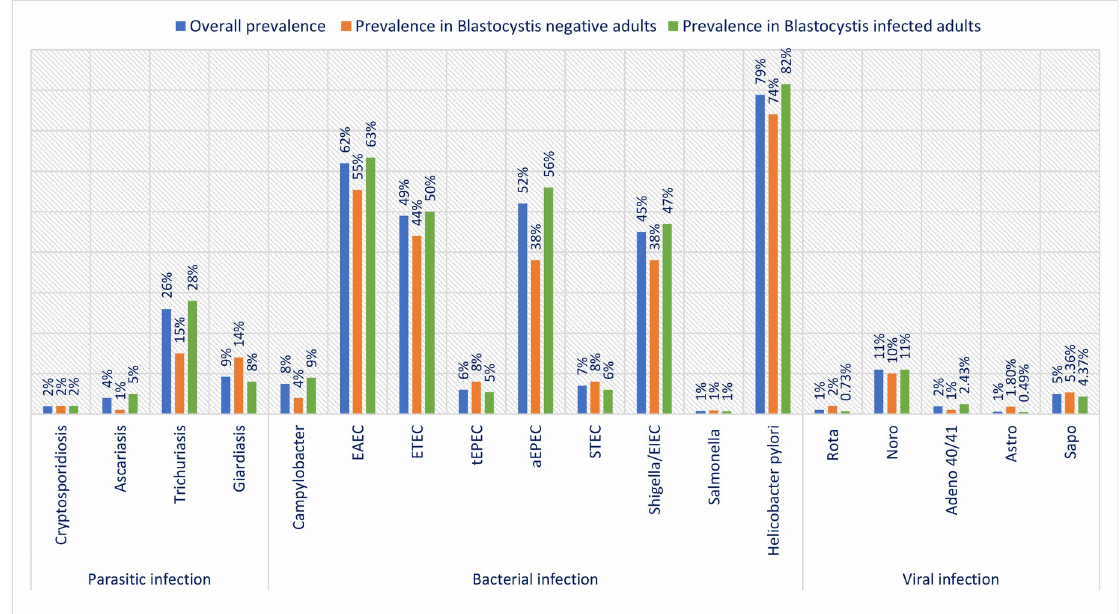
Fig 2. Prevalence of asymptomatic enteric infections according to infection with Blastocystis infection among malnourished adults in Bangladesh.